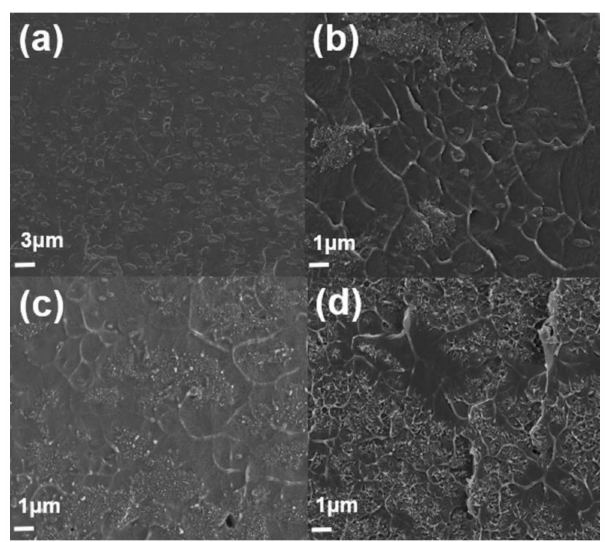
Figure 9. The SEM image of PMMA / PS / CNT composites. ( a ) PMMA / PS(90 / 10), ( b ) PMMA / PS / CNT (90 / 10 / 0.5wt%), ( c ) PMMA / PS / CNT(90 / 10 / 1wt%), and ( d ) PMMA / PS / CNT(90 / 10 / 3wt%).